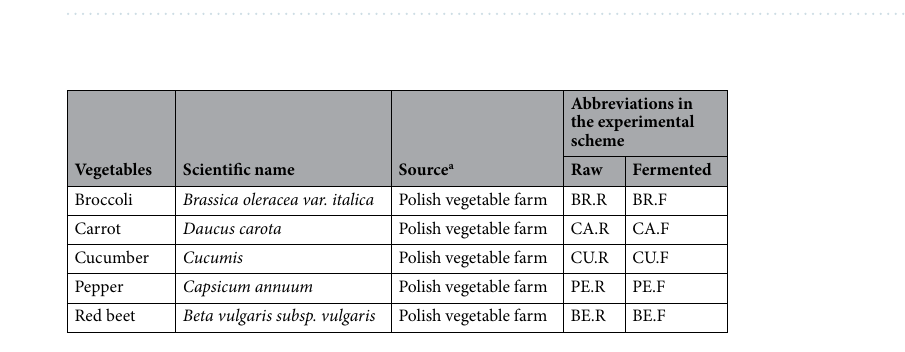
Table 1. Lactic acid bacteria involved in the fermentation of selected vegetables 2,13,16 .